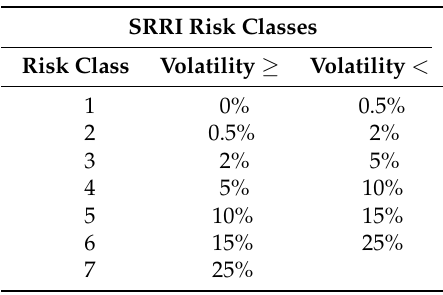
Table 1. SRRI risk classes on corresponding volatility buckets as defined in the ESMA 10-673